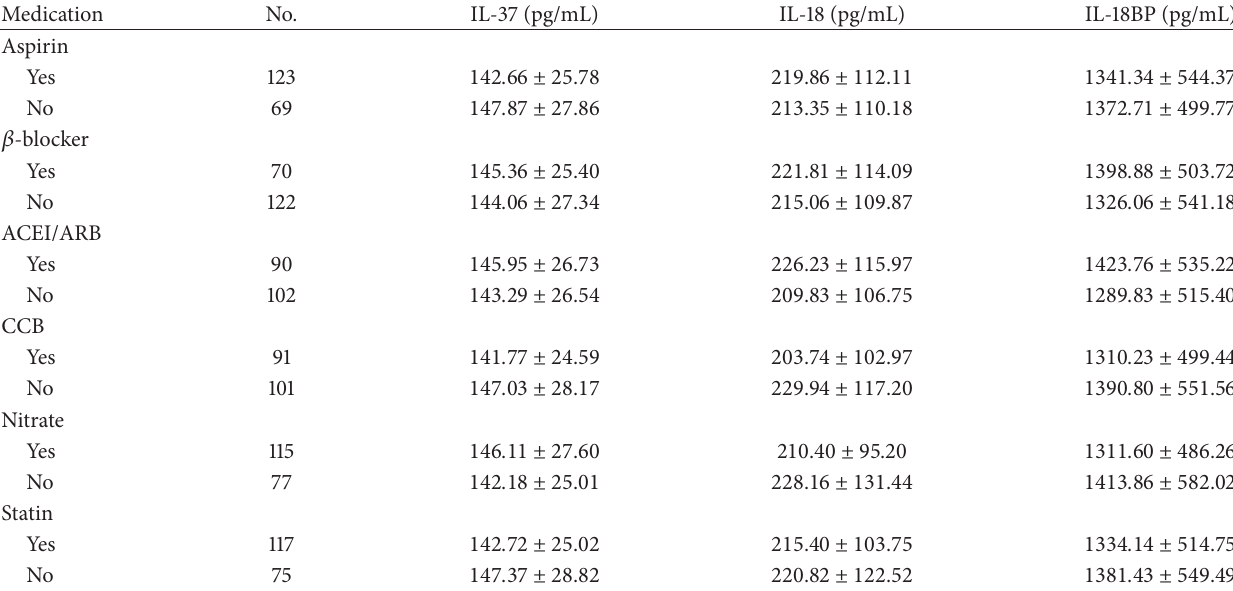
Table 3: Plasma biomarker levels in CAD patients according to medication.